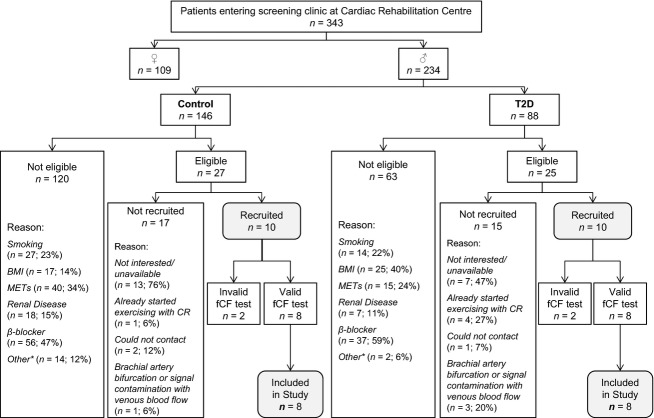
Flowchart of participant recruitment. Note that potential participants may have been deemed ineligible due to one or more criteria (therefore the n values for the reasons participants were “not eligible” do not sum to the total number of participants who were not eligible). *Other reasons for exclusion were: myocardial ischemia during exercise (n = 1), Churg–Strauss syndrome (autoimmune vasculitis; n = 1), heart transplant patient (n = 1), age (n = 2; 17 and 85 years), unable to do baseline assessment of aerobic fitness (n = 3; due to: wheelchair, high blood pressure, musculoskeletal issues), participation vetoed by cardiologist without provided reason (n = 2), impaired glucose tolerance (n = 6). BMI, body mass index; CR, cardiac rehabilitation; fCF, forearm critical force; METs, metabolic equivalents.